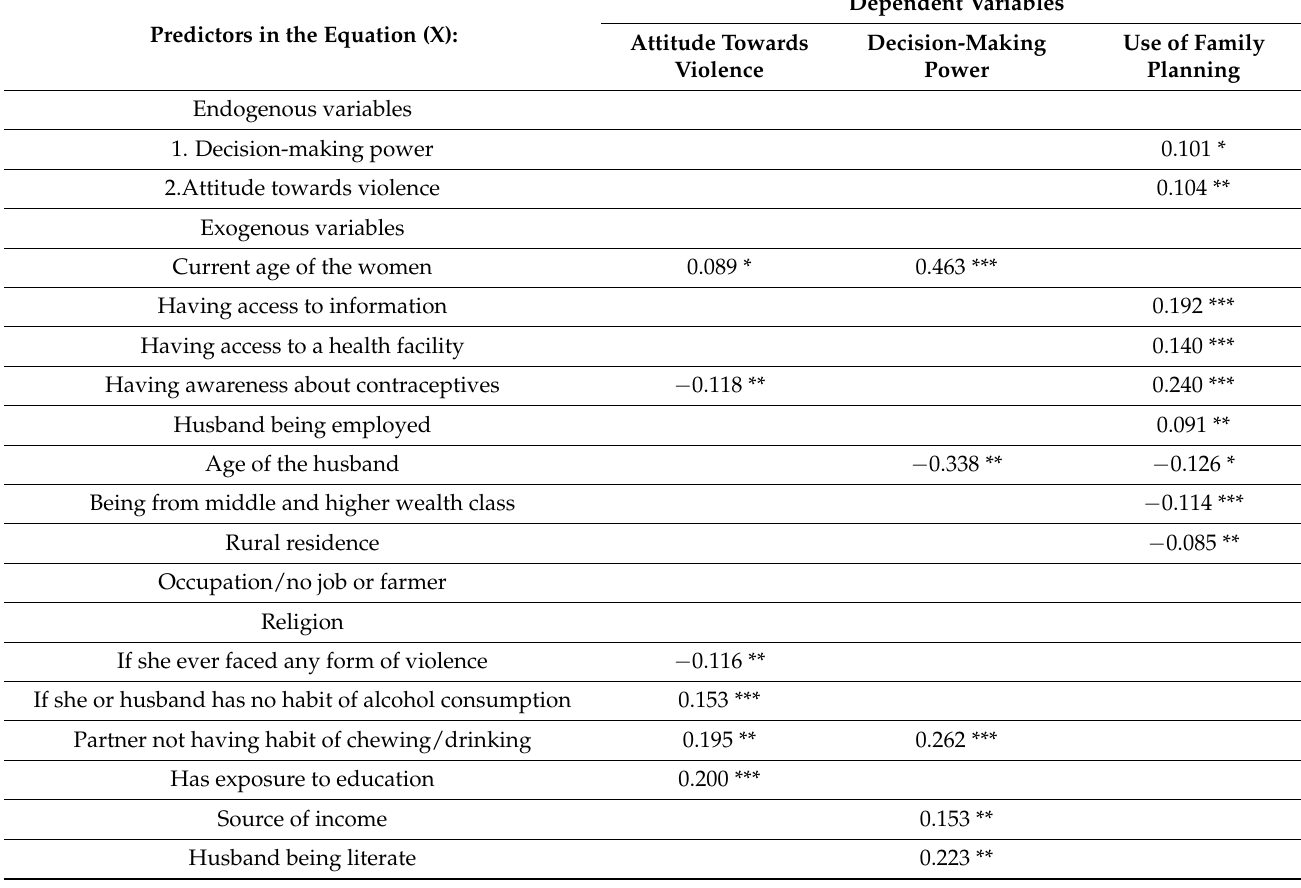
Table 6. Standardised path coefficients of the latent variable SEM (n = 746), Western Ethiopia, 2020.